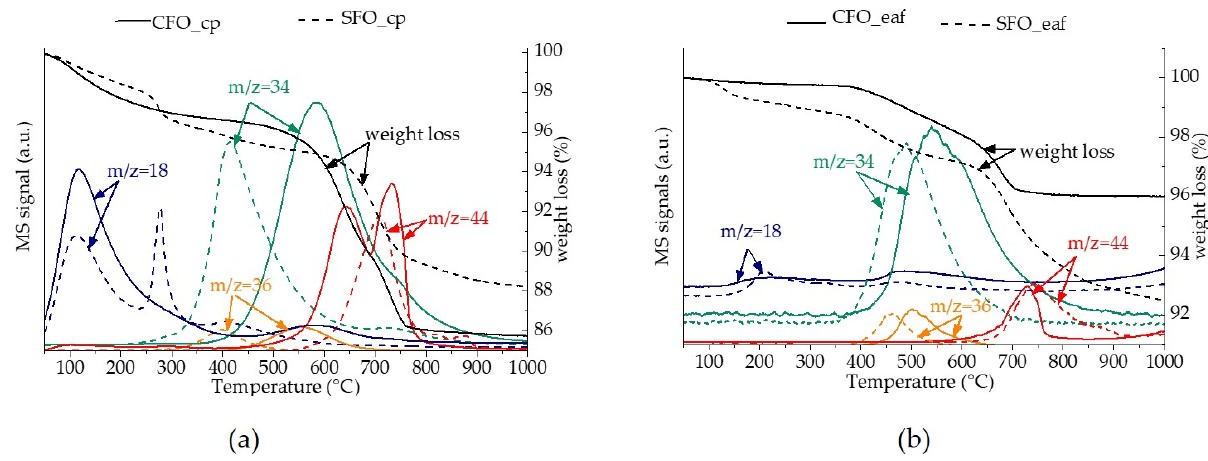
Figure 4. TG-MS analysis under air on 18 O-exchanged CFO (solid lines) and SFO (dashed lines). ( a ) CFO and SFO synthesized by the complexation route. ( b ) CFO and SFO synthesized by electric arc fusion. Black curves: TG analysis, colored curves: mass spectrometry analysis.